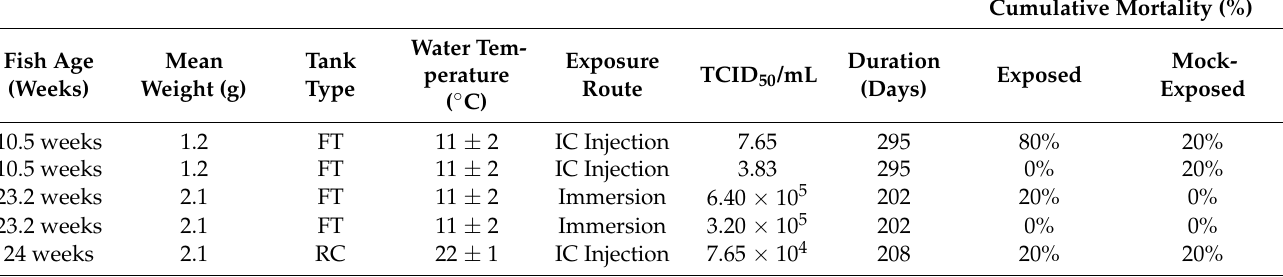
Table 1. Summary data for pilot in vivo experiments in juvenile Great Lakes lake sturgeon ( A. fulvescens ; n = 5/treatment/pilot experiment) that were exposed to the newly isolated Lake Sturgeon herpesvirus under multiple conditions and exposure routes. TCID 50 , Tissue culture infec- tious dose 50; IC, intracelomic; FT, flow-through; RC,